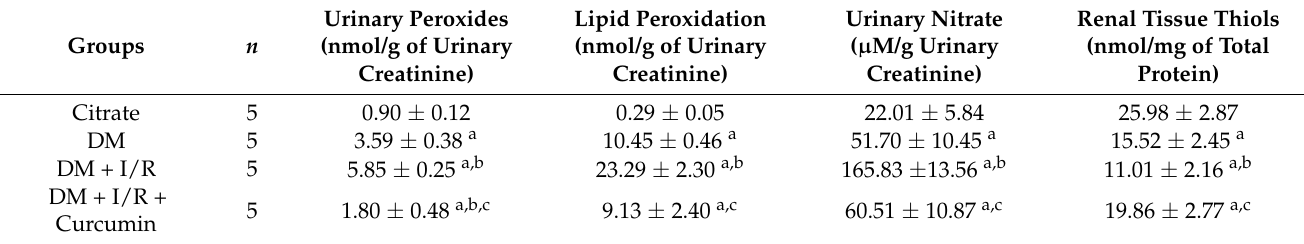
Table 7. Oxidative